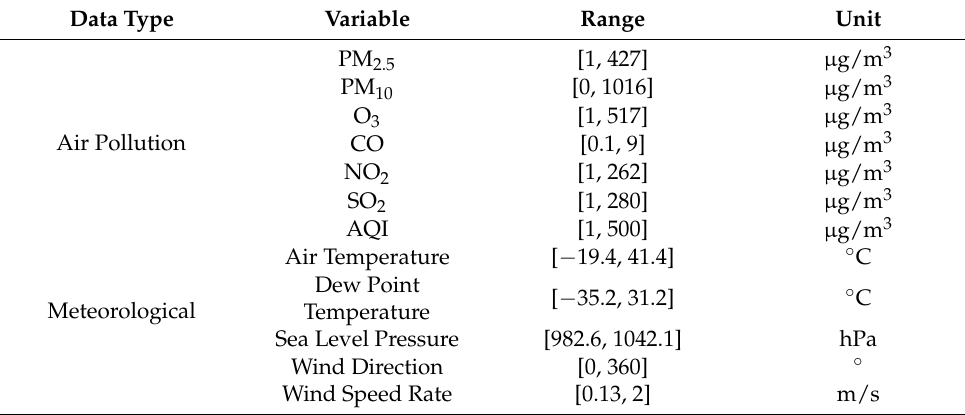
Figure 1. The distribution of air quality monitoring stations in China. Table 1. Overall input variables for PM 2.5 concentration forecasting models.